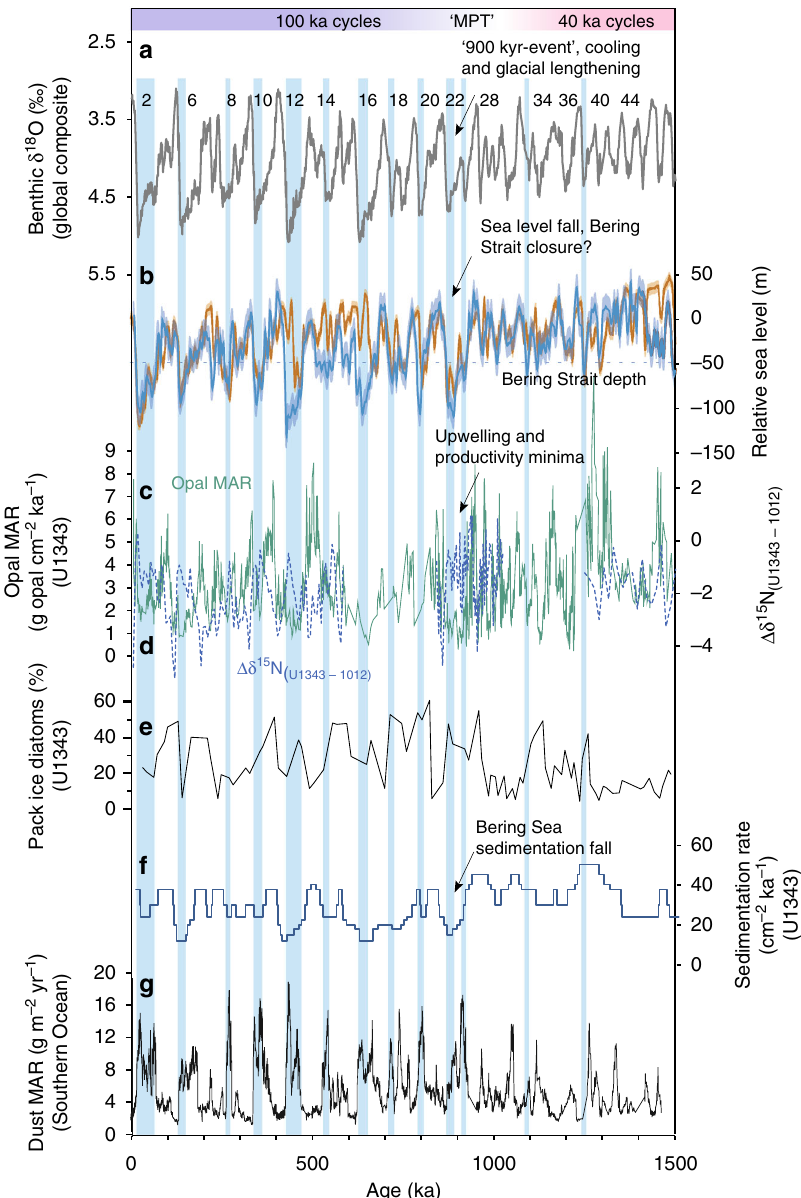
Fig. 2 Bering Sea productivity, nutrient utilization and sedimentation rate proxy records compared with global glacial-interglacial cycles for the past 1500 ka. The Mid-Pleistocene Transition (MTP) represents the transition from 40 ka glacial cycles to 100 ka glacial cycles. Major sea level falls below the current Bering Strait sill depth (horizontal dashed line) are indicated with blue vertical bars. From ~900 ka, reduced glacial productivity occurs with increased nutrient utilization. a Global benthic foraminiferal δ 18 O composite (grey) LR04 30 . b Global sea level estimates from Site 1123 (blue) 2 and the Mediterranean (orange) 3 . c Opal mass accumulation rate (MAR) as a proxy for productivity (green) for Site U1343 25 . d Bulk sediment δ 15 N for Site U1343, with Site 1012 48 subtracted ( Δδ 15 N). U1343 δ 15 N data from 850 – 1020 ka are from this study, other are data are previously published 39,68 . e Site U1343 percentage of diatom assemblages regarded as indicative of pack ice 69 . f Sedimentation rate (cm ka − 1 ) for Site U1343 33 . g Dust MAR from the